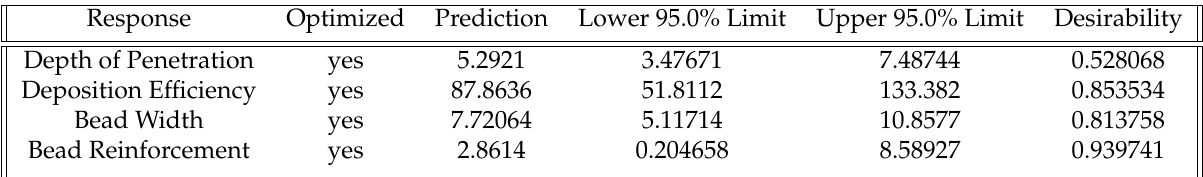
Table 9. Optimum Response Values